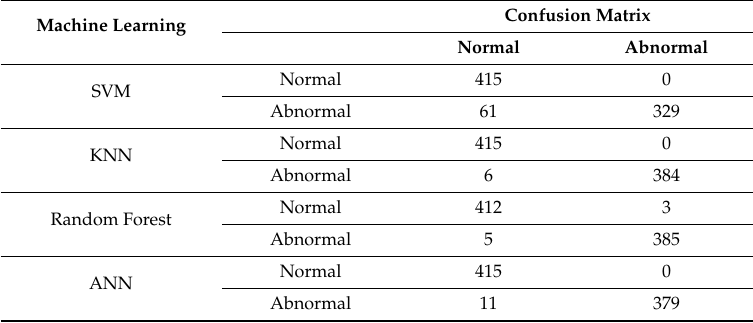
Table 17. Confusion matrix of proposed